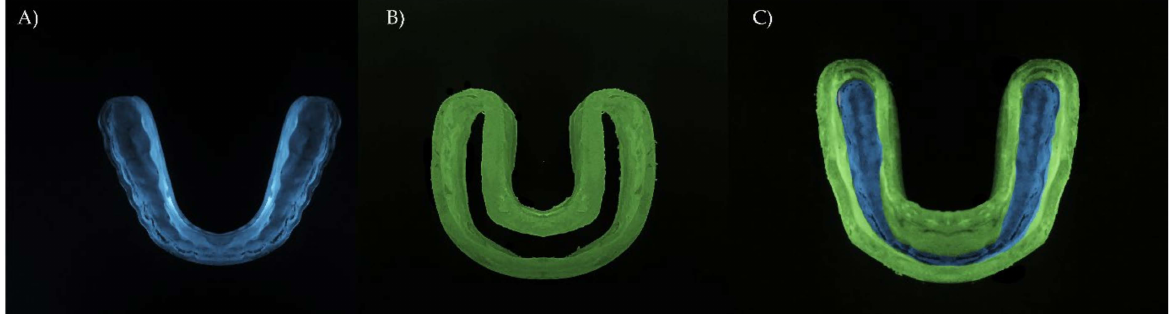
Figure 1. Hybrid occlusal splint mouthguard design (Kalman et al., 2022 [5]). ( A ) Polycarbonate as a rigid inner portion, ( B ) ethylene vinyl acetate used in the axial flexible flanges, and ( C ) the final modulated appliance assembled as the novel HMG.